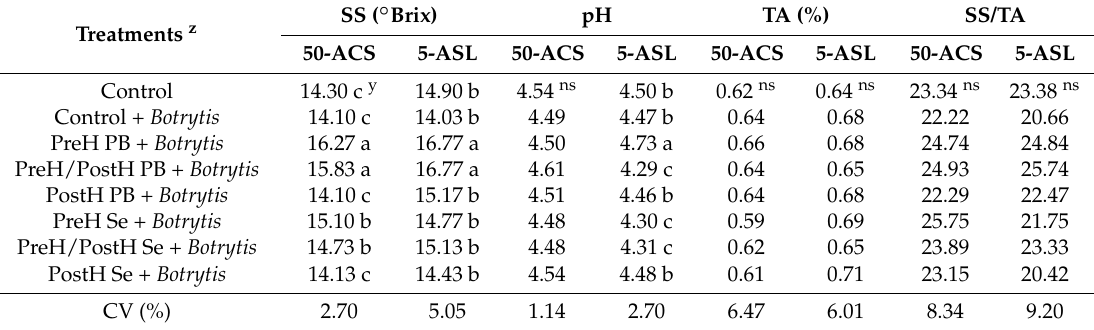
Table 4. Soluble solids content (SS), pH, titratable acidity (TA), and SS/TA ratio of ‘BRS Isis’ seedless table grapes subjected to different preharvest (PreH), pre- and postharvest (PreH/PostH), and postharvest (PostH) treatments, at 50 days after cold storage (50-ACS) and at five days after shelf-life (5-ASL). Treatments